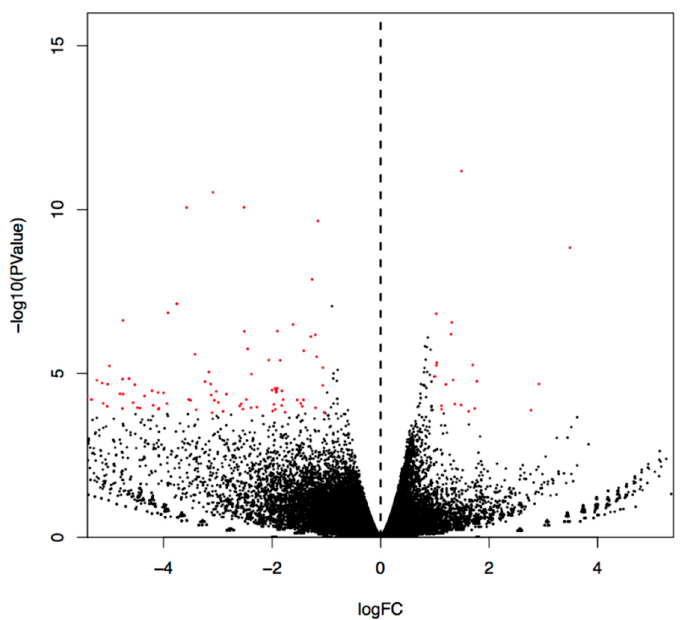
Figure 1. Volcano plots of significantly differentially expressed genes. log FC (fold-change) (X-axis) and p-value (Y-axis) of differentially expressed genes (DEGs) comparing control versus Se-Met-treated 3×Tg-AD mice. Each dot represents a single DEG, and a red dot illustrates statistical significance ( p = 0.05). Left-downregulated; Right–upregulated.